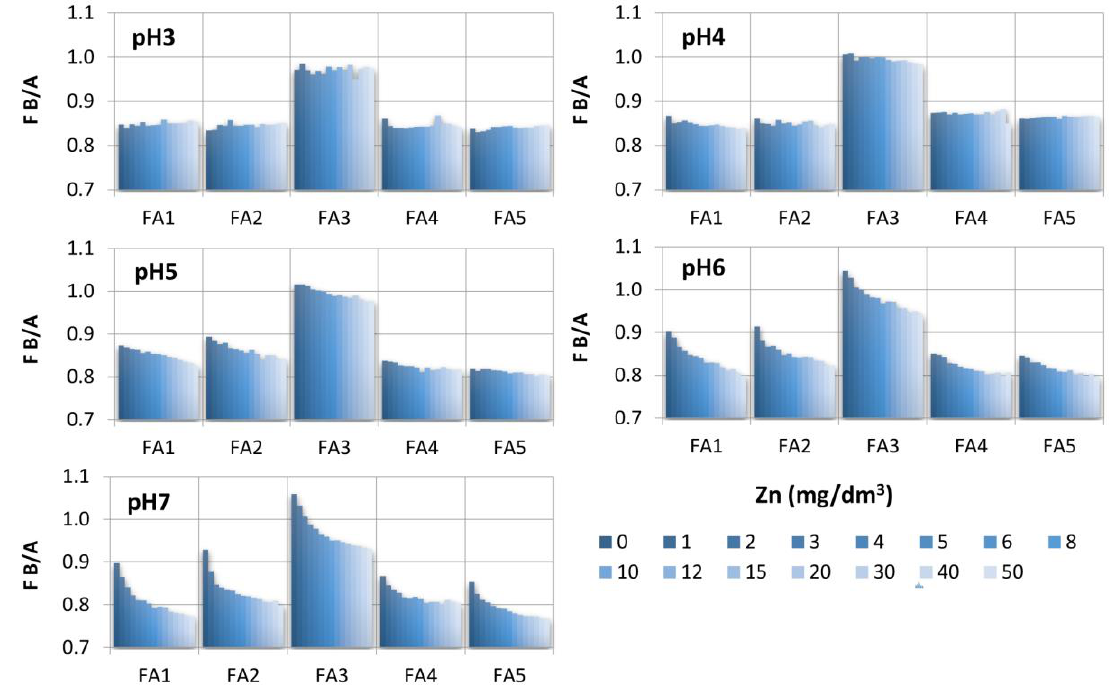
Figure 2. Differences in the quenching of A and B peaks expressed as changes in ratio of B and A intensities as a function of increasing Zn(II) concentration.